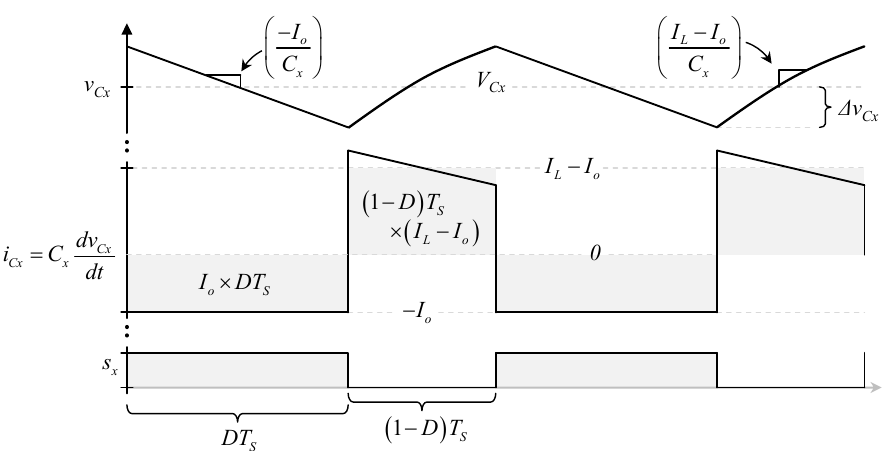
0 Figure 4. Important waveforms related to the inductor from top to bottom, respectively: inductor current, inductor voltage, and switching function.